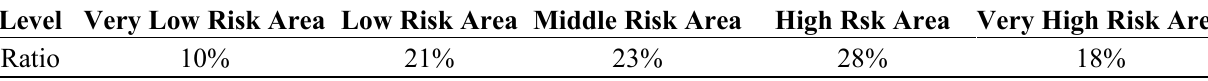
Figure 6. Zoning map of the desertification disaster risk in Naiman Banner. Table 4. The area ratio of the desertification disaster risk types in Naiman